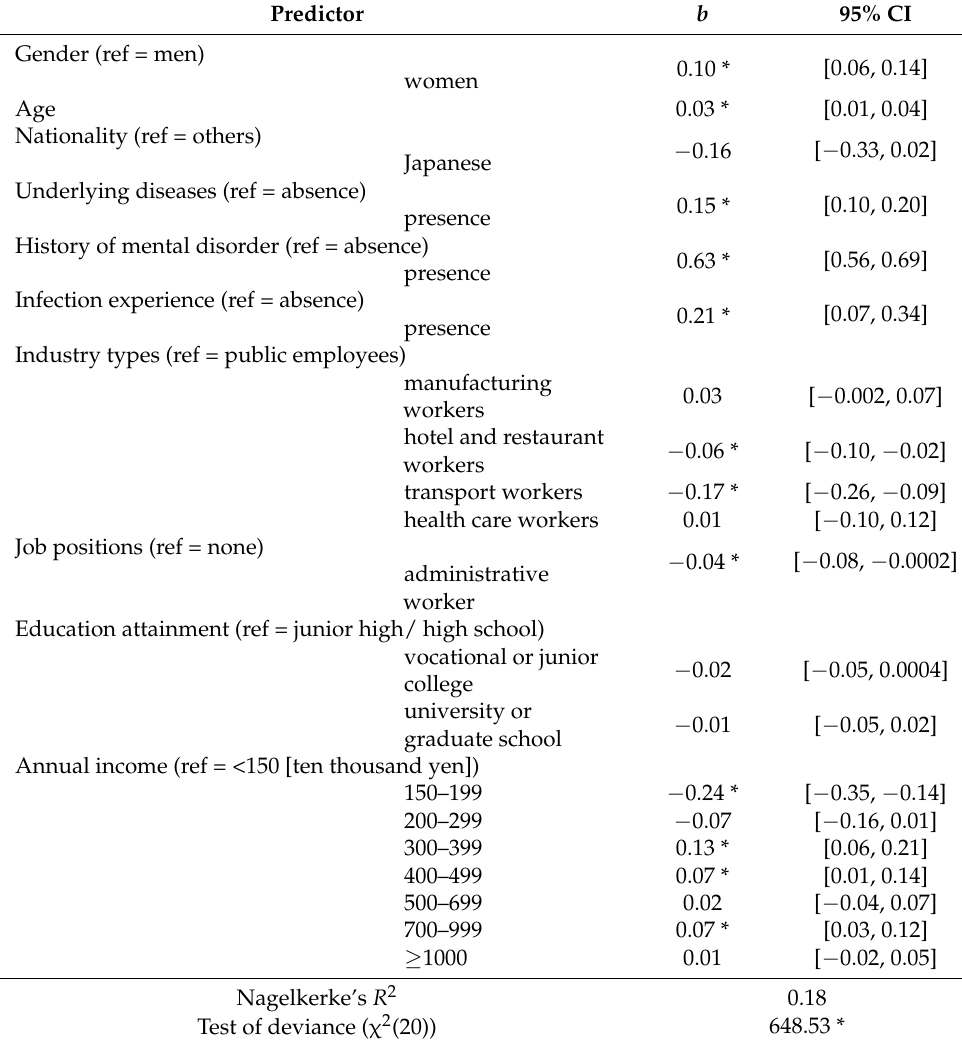
Table 2. Stepwise Poisson regression analysis of K6